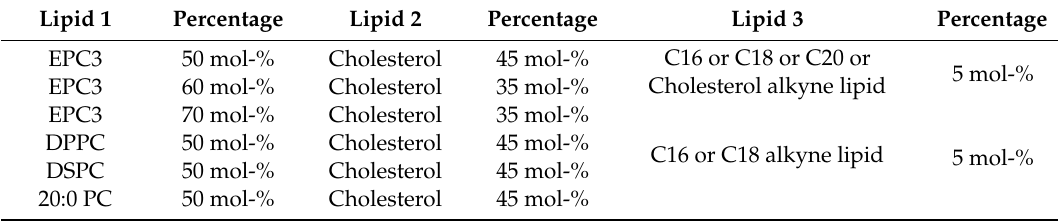
Table 1. Lipid compositions of liposomal formulations in